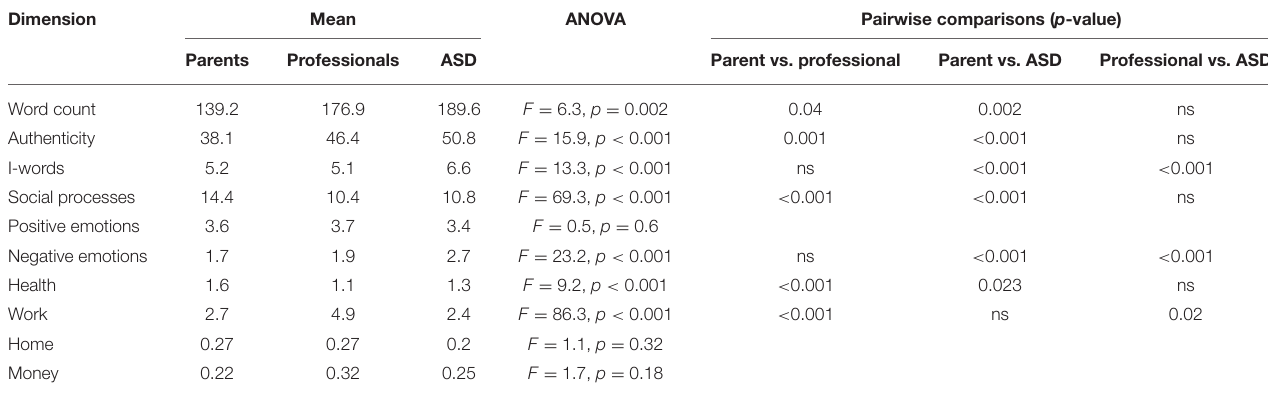
TABLE 5 | LIWC across user categories based on personal status. Dimension Mean ANOVA Pairwise comparisons ( p -value)